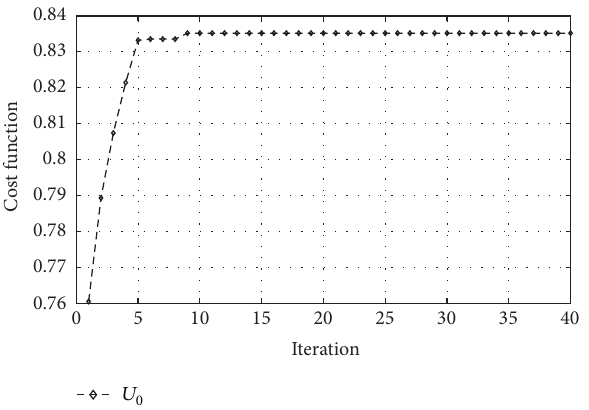
Figure 5: Utility function of the secondary users.